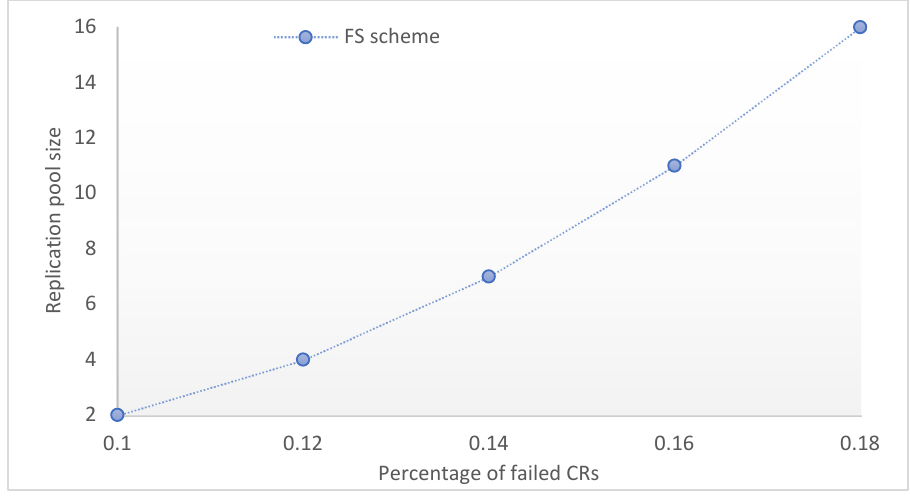
Figure 3. Pool size under different percentage of failed CRs.